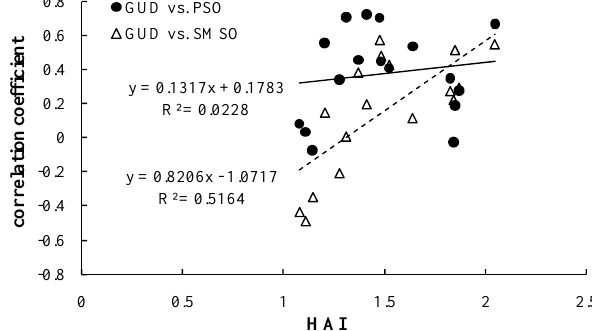
Fig. 10. Trend of correlations between GUD (Green-up Onset Date) and PSO (Precipitation Spring green-up Onset date)/SMSO (Soil Moisture Spring green-up Onset date) among meteorological stations along a gradient of HAI (the solid circle is the correlation between GUD and PSO, the hollow triangle is the correlation between GUD and SMSO).